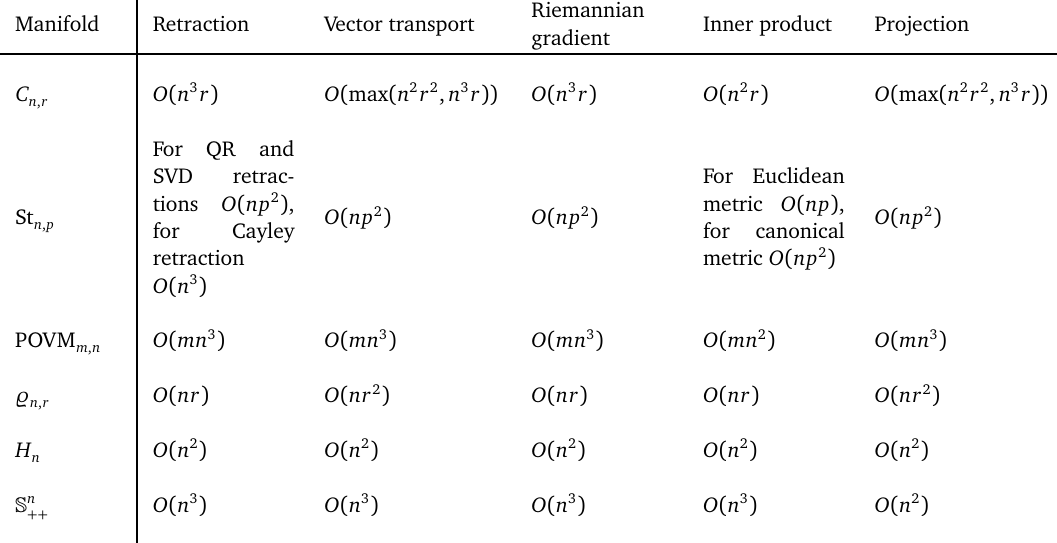
Table 3: Complexity of optimization primitives for all manifolds implemented in the QGOpt